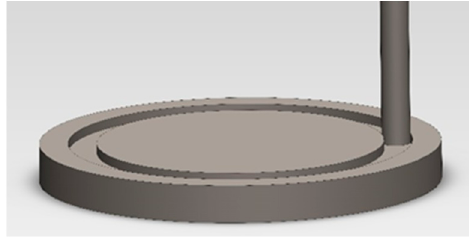
Figure 3. Scheme of the pin-on-disc method .